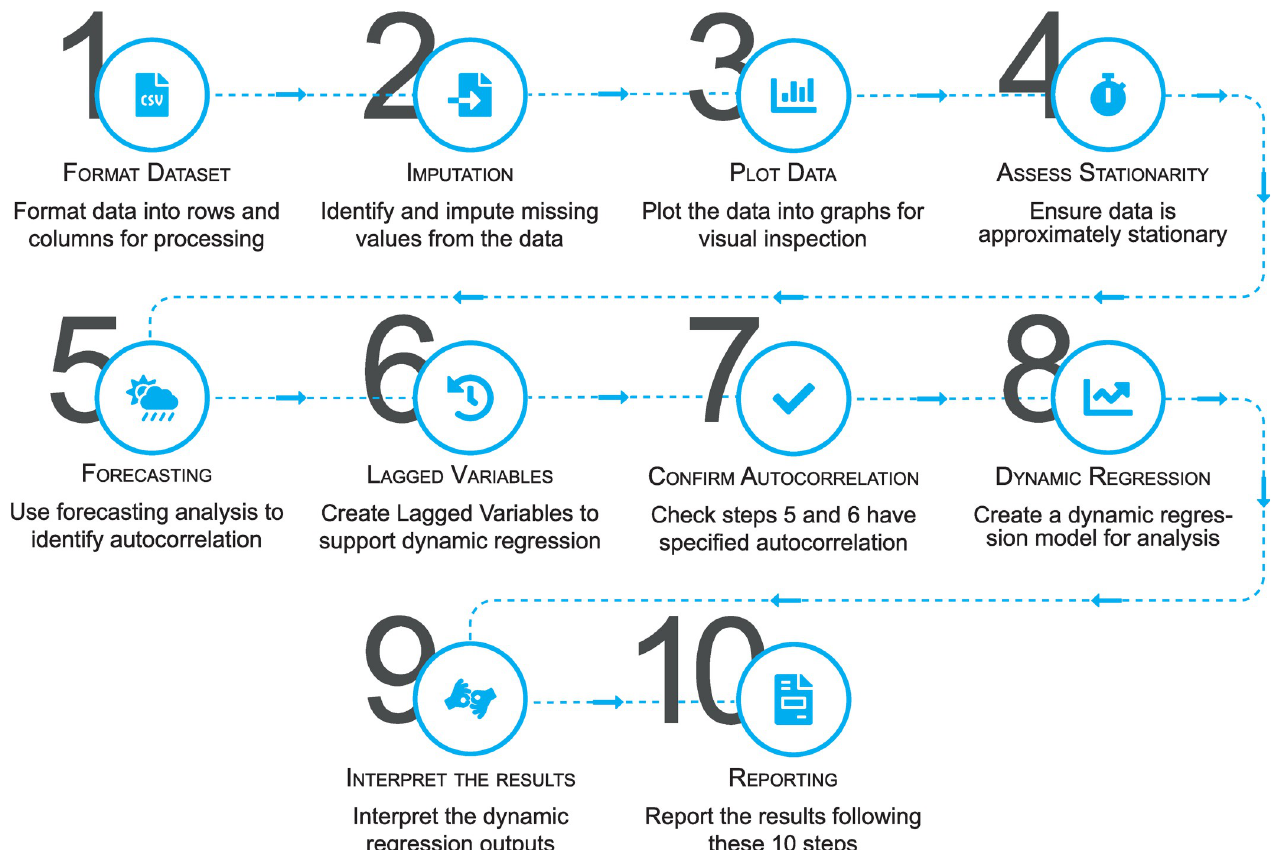
Fig 3. Flowchart representation of the methodological approach within this study for analysing timeseries data with dynamic regression.